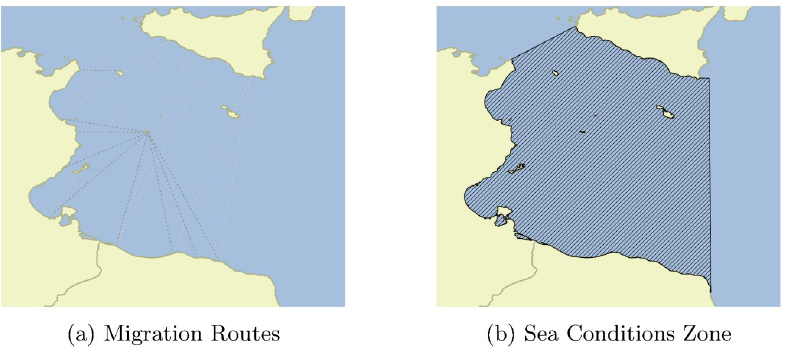
Fig 1. Region of Study migration passages and smuggling hubs (a) and area used for calculating sea conditions (b). Map of smuggling routes is recreated based on information from the IOM [24]. Sea condition zone is authors’ projection. Data on sea conditions is from the Copernicus marine environment monitoring service. Boundary files are from GADM [25].